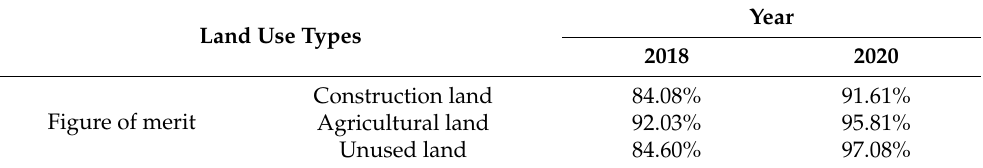
Table 7. The figure of merit for the simulation results of the three land use types in 2018 and 2020. Land Use